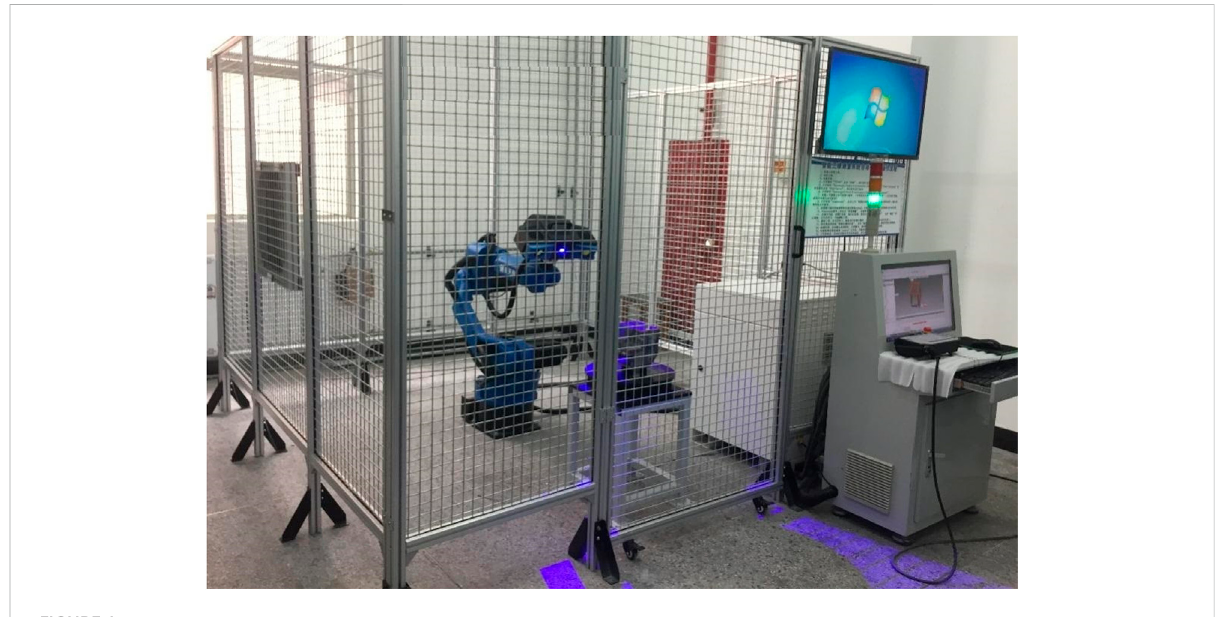
FIGURE 1 Composition of the automated measurement